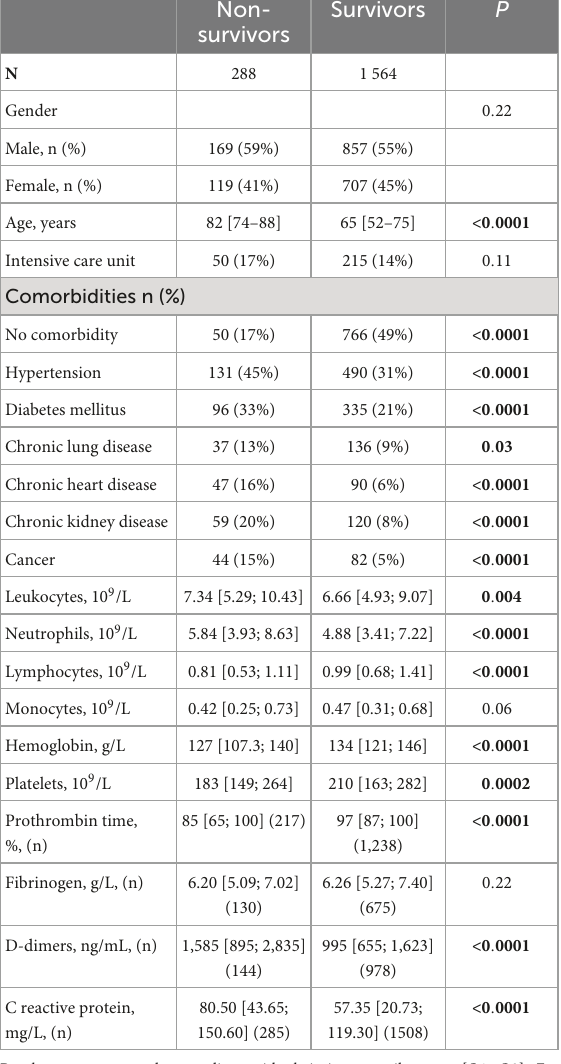
TABLE 1 Population